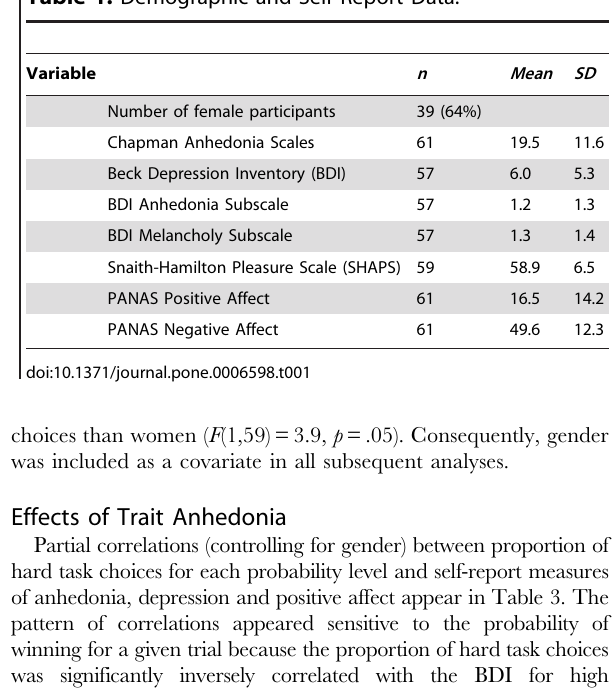
Table 2. Zero-order correlations between self-report measures.